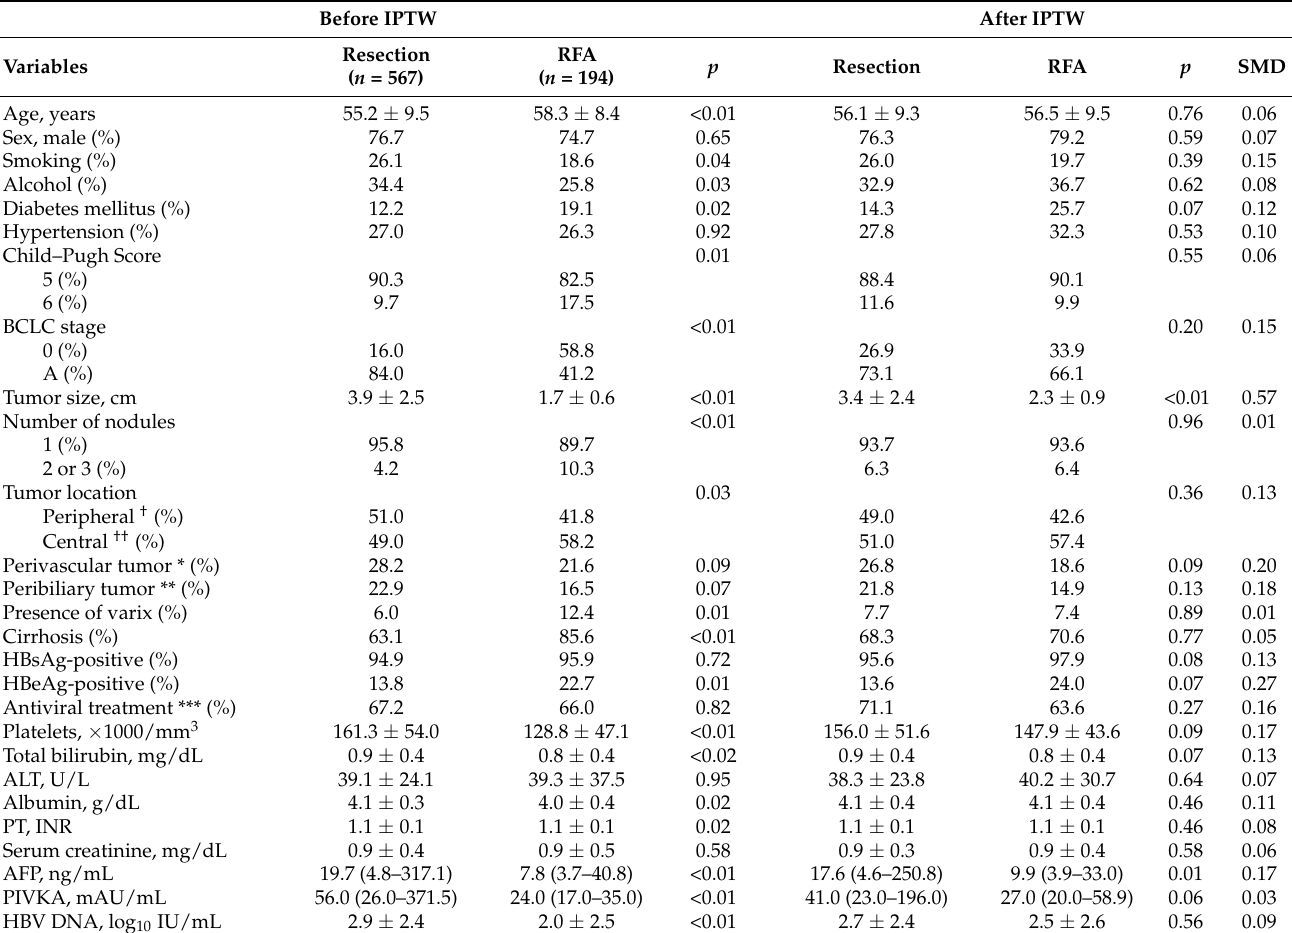
Table 1. Baseline characteristics of the entire hospital cohort before and after